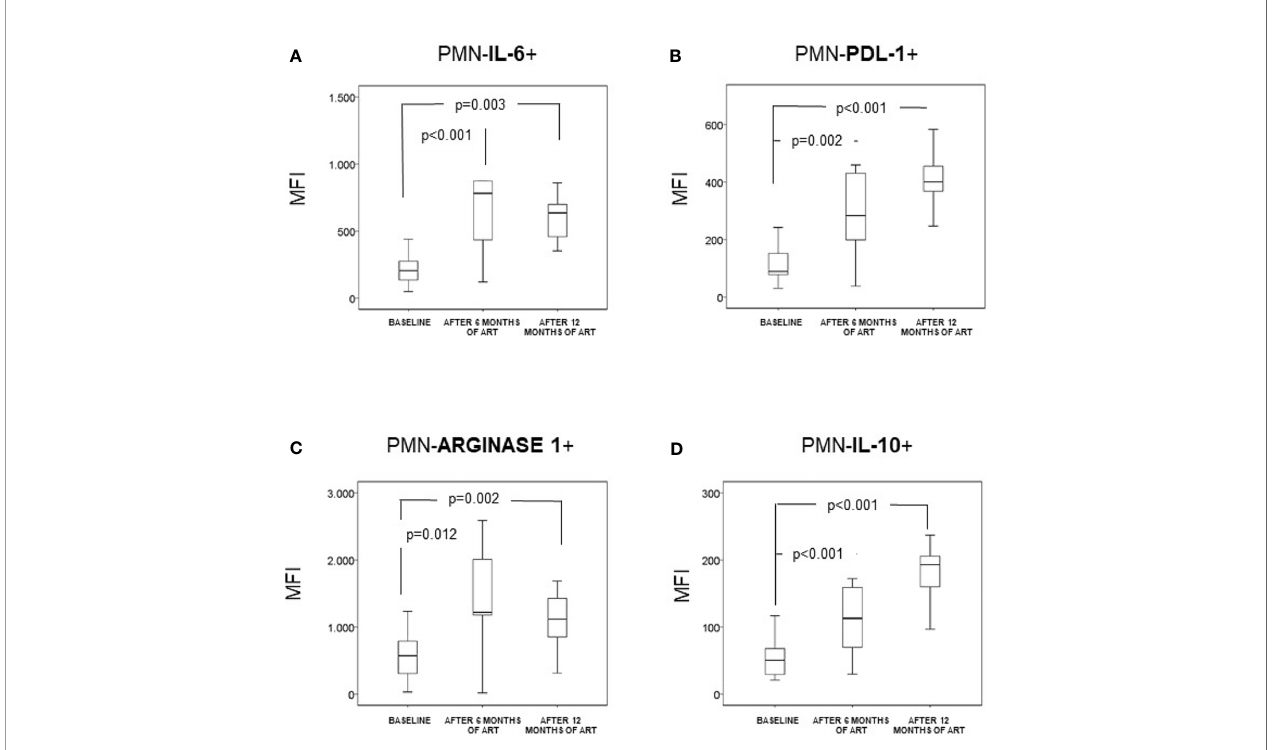
FIGURE 1 | Neutrophils (CD14-CD15+CD16+) (PMN) expression of intracellular IL-6 (A) , intracellular arginase 1 (B) , membrane PDL-1 (C) , and intracellular IL-10 (D) in naïve HIV-infected patients (n = 35). They were analyzed at baseline and after 6 and 12 months of antiretroviral treatment. Data are provided as median, interquartile range (boxes) and range of the mean fl uorescence intensity (MFI), at baseline and after 6 and 12 months of antiretroviral